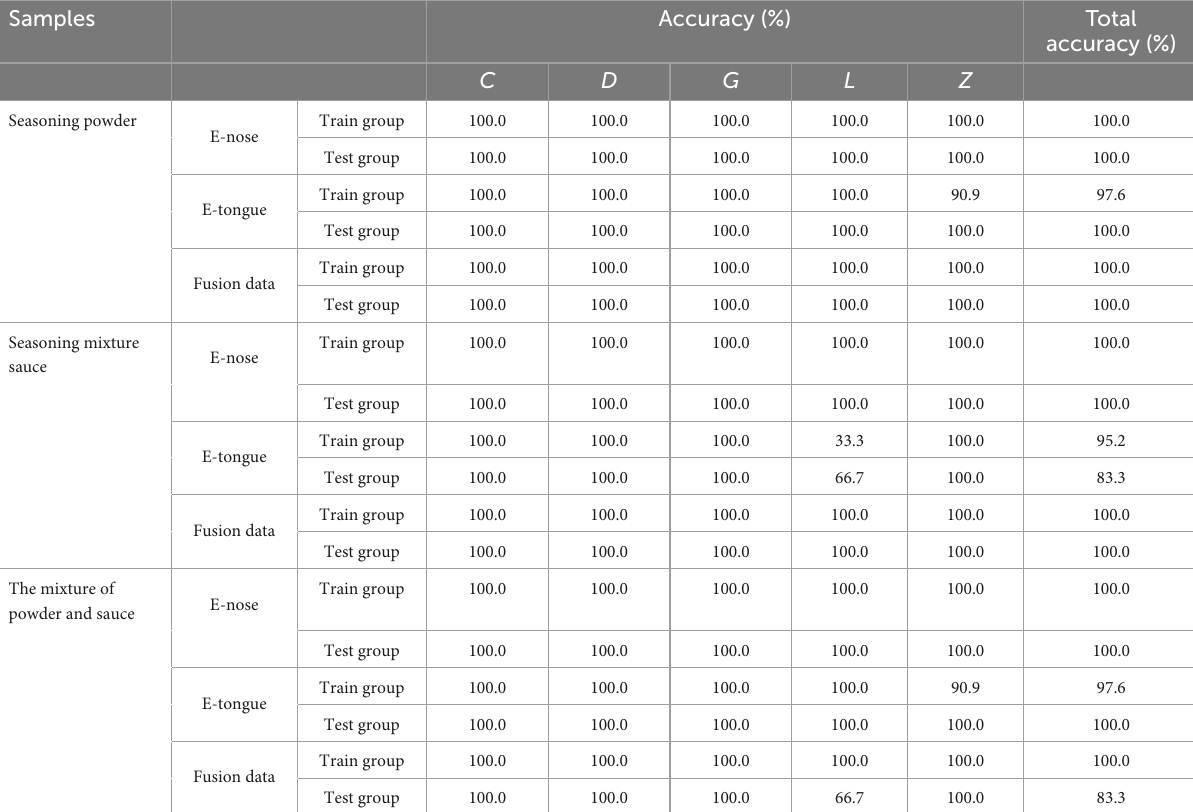
TABLE 2 Results of multilayer perceptron neural networks analysis (MLPN) models.